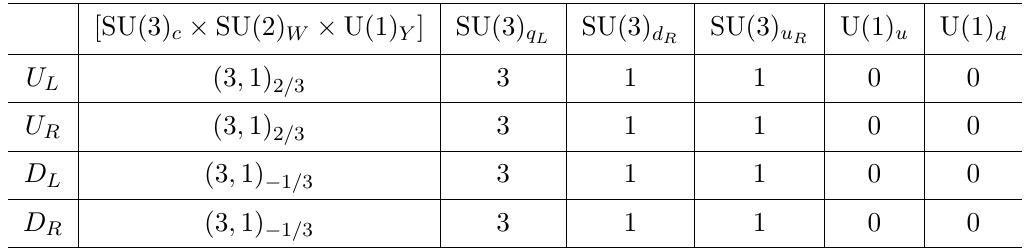
Additional matter content of a renormalizable version of the construction presented in the main text, added onto the quark and scalar fields listed in table 1. Note that the fields U and D are simply vector-like quarks with the same representations under the MFV group as the left-handed quarks in table